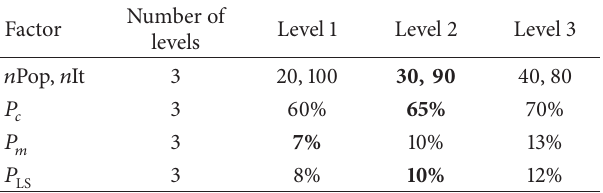
Table 1: Factors and factors